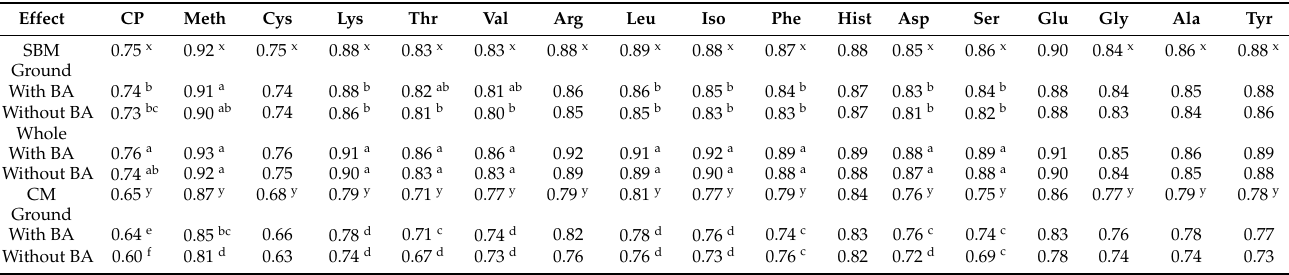
Table 5. Effect of protein source (PS), diet structure (DS) and butyric acid (BA) supplementation on apparent ileal digestibility of protein and amino acids in broilers 1 at 36 days of